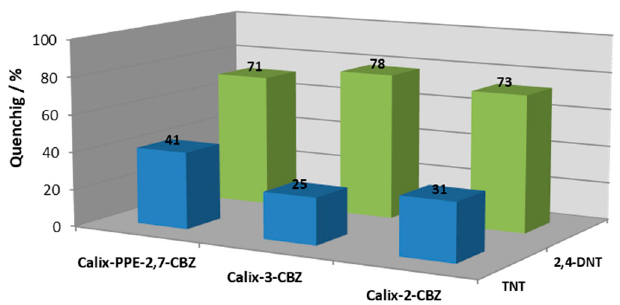
Figure 6. Fluorescence quenching responses of Calix ‐ PPE ‐ 2,7 ‐ CBZ (4 nm films) and Calix ‐ CBZs (1.8 nm films) upon exposure to saturated TNT and 2,4 ‐ DNT vapours for 30 s at 25 °C ( λ exc = 360 nm).